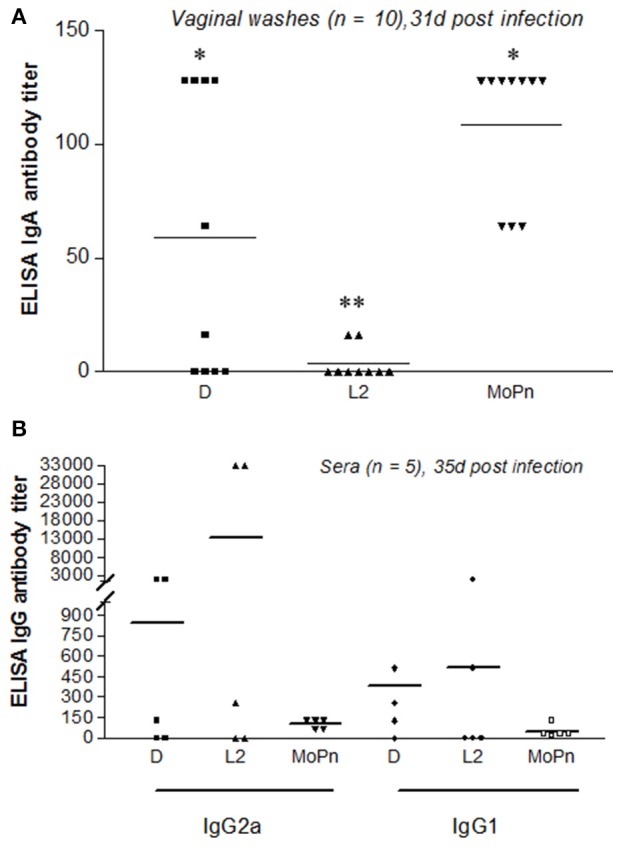
Mucosal and systemic antibody responses following infection with C. trachomatis (serovars D, L2) and C. muridarum (MoPn). (A). Vaginal washes were collected 31 days post infection (n = 10) and assayed for the presence of anti-chlamydial secretory IgA. (B) Sera were collected 35 days post infection (n = 5) and assayed for the presence of anti-chlamydial IgG2a and IgG1. Antibody titers are expressed for individual mice as the highest dilution that produced ≥3-fold the absorbance reading of the control (sham-infected) vaginal wash and sera samples. Bars represent mean antibody titer per group.**p < 0.001 (L2 vs. MoPn), *p < 0.05 (D vs. L2; D vs. MoPn), One way ANOVA.